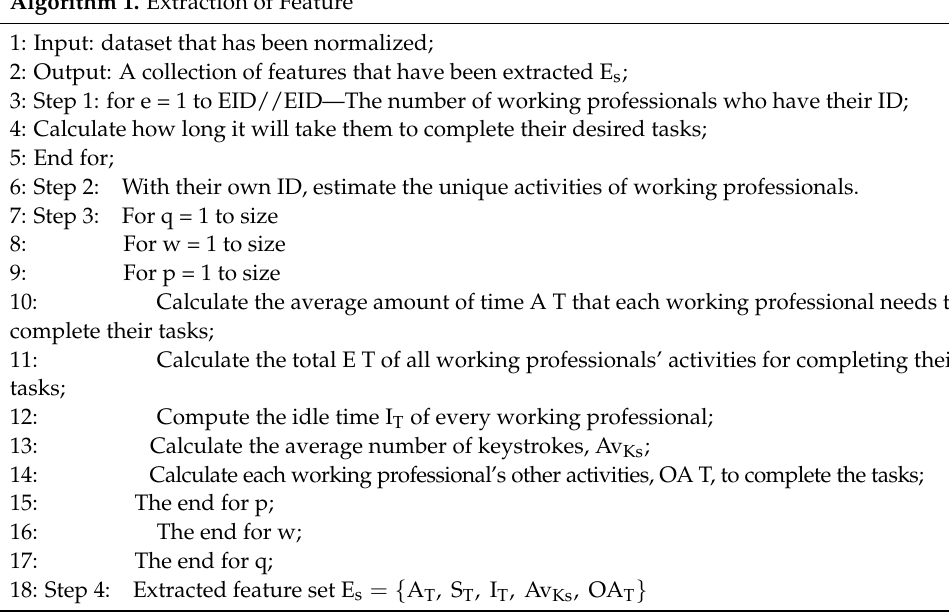
Algorithm 1. Extraction of